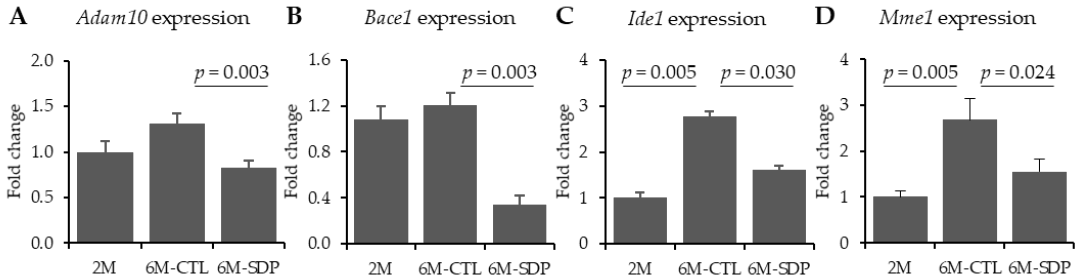
Figure 2. Effects of SDP supplementation on gene expression of enzymes related to aberrant APP processing. Panels ( A – D ) show the expression of Adam10 , Bace1 , Ide1 , and Mme1 , respectively, in cortex tissue. Results are expressed as mean ± SEM ( n = 5–6 mice). Statistics: ANOVA (Fisher’s multiple comparison test). Adam10 : disintegrin and metalloproteinase domain-containing protein 10; Bace1 : beta-secretase 1 ; Ide1 : insulin-degrading enzyme ; Mme1 : neprilysin .